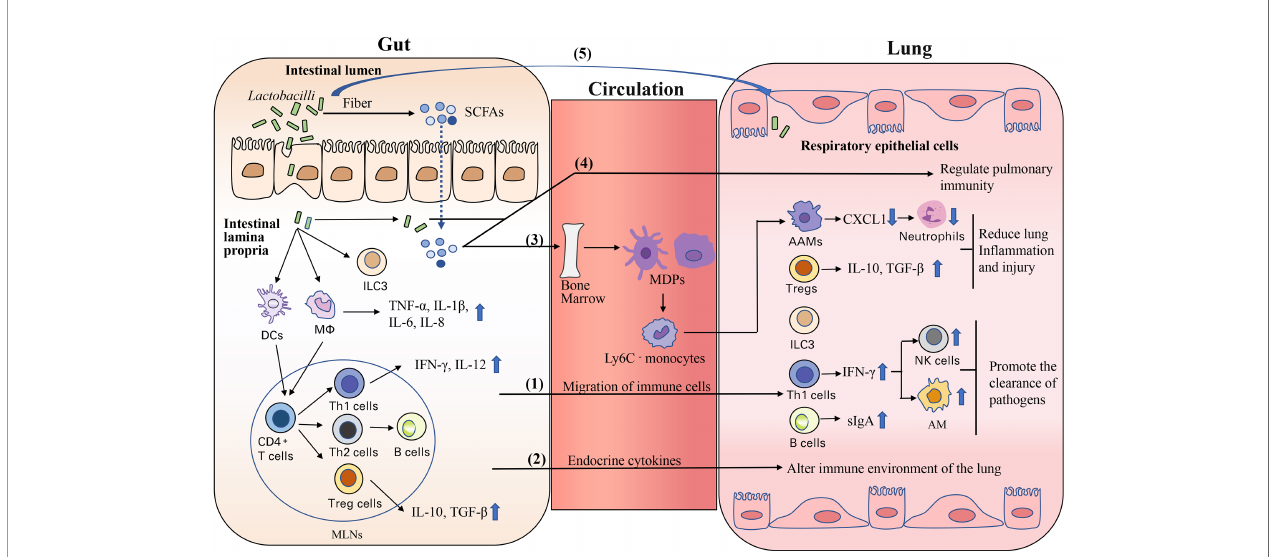
FIGURE 1 | Potential mechanisms of Lactobacilli to modulate respiratory immunity via the gut-lung axis (1). Migration of activated immune cells and cytokines from mesenteric lymph nodes (MLNs) and intestinal lamina propria to the lung through the circulation (2). Some endocrine cytokines (such as TNF- a , IL-6) may migrate to the lung tissue through the circulation, and then alter immune environment of the lung (3). SCFAs affect bone marrow hematopoiesis and promote the conversion of macrophage and DC progenitors (MDPs) into Ly6C-monocytes, which reaches lung tissue and differentiates into anti-in fl ammatory alternatively activated macrophages (AAMs); AAMs inhibit chemokine CXCL1 production thus leading to reduced neutrophils recruitment in lung tissue (4). In the intestinal lumen, Lactobacilli or their components and production of metabolites (such as SCFAs) are taken up by intestinal epithelial cells and then enter to the lung via the circulation (5). Lactobacilli or their components from the intestinal lumen reach lung directly via microbreathing or esophageal re fl